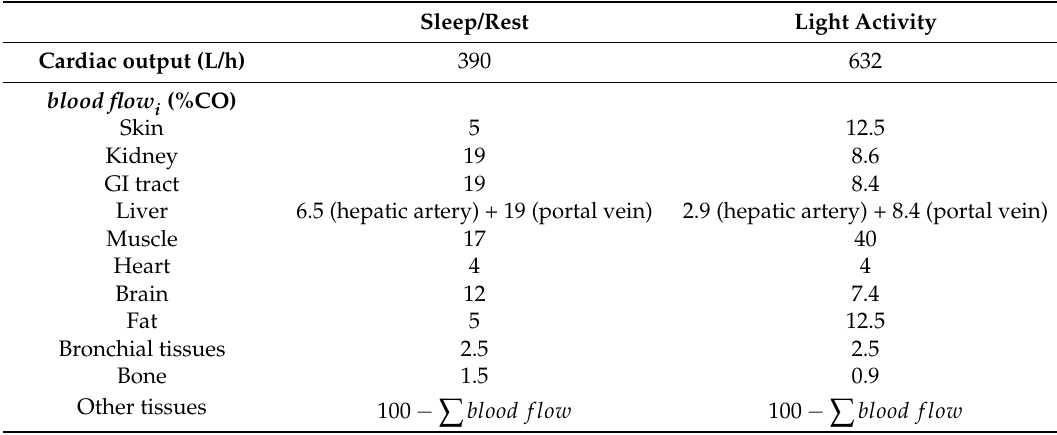
Table 1. Cardiac output ( CO ) and blood flow i distribution during rest and light exercise [63–65]. Sleep/Rest Light